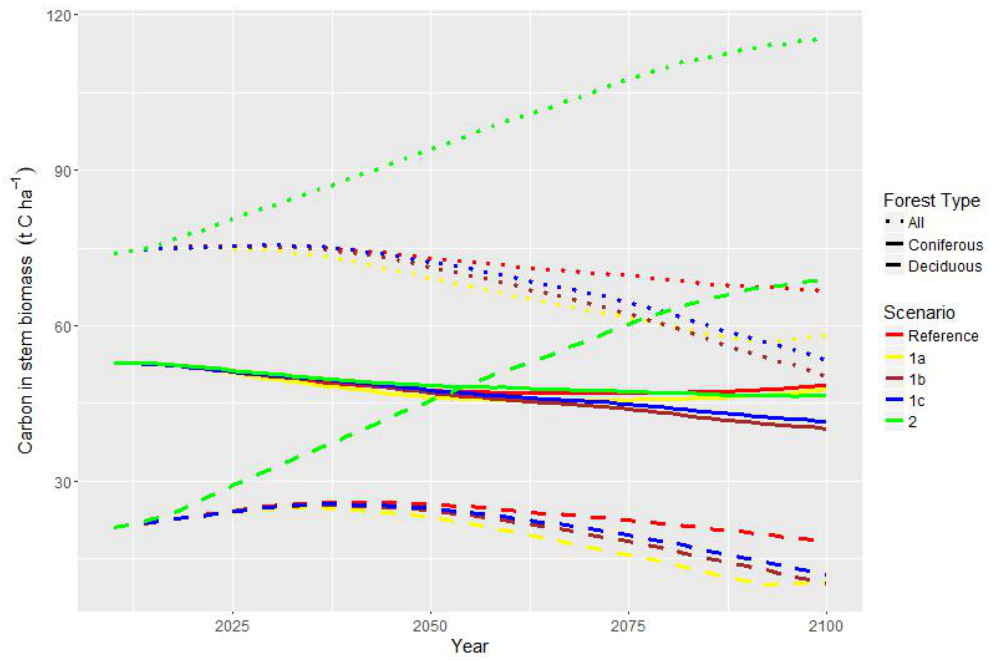
Figure 3. Development of the carbon mass in stem wood in different forest management scenarios separated by coniferous and deciduous forests and as total carbon stock.